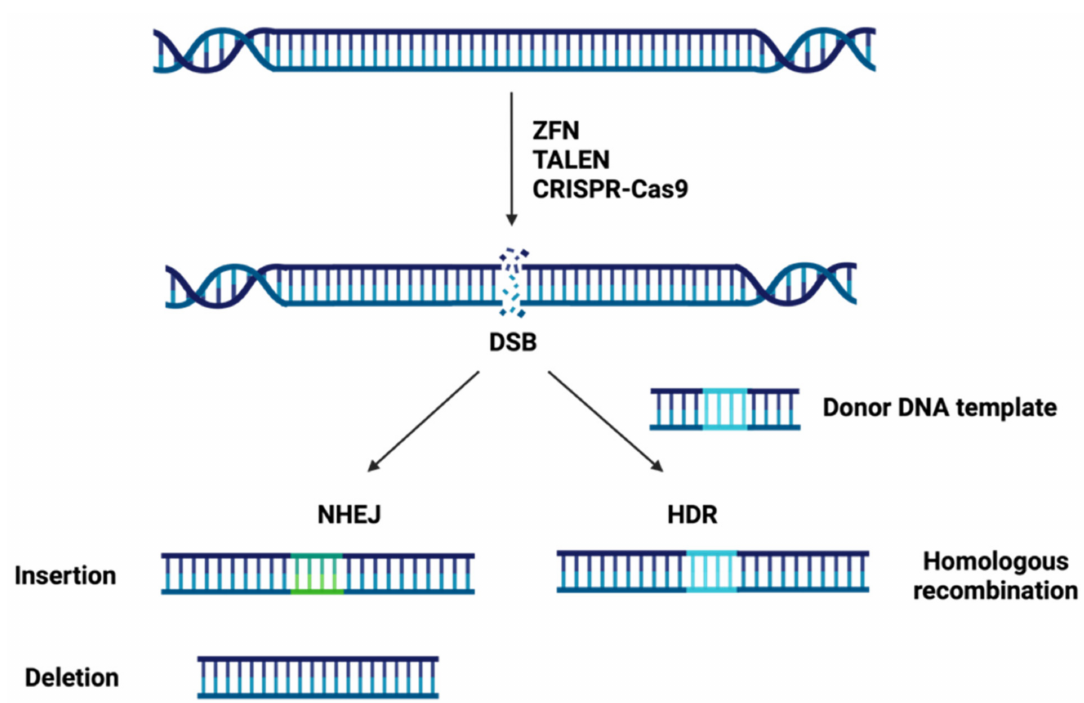
Figure 2. Cellular repair mechanisms of double-strand DNA breaks (DSBs). Site-specific nuclease systems carry out precise and efficient genome modification by producing a DSB, which would be corrected by nonhomologous end-joining (NHEJ) or homology-directed repair (HDR)